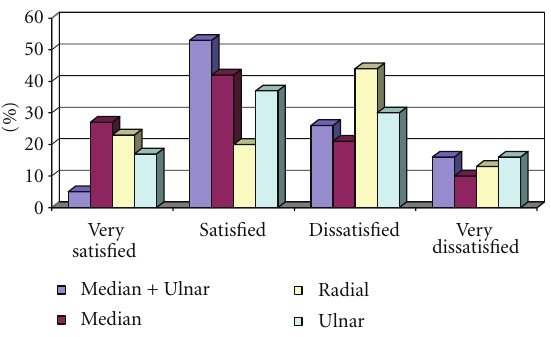
Figure 2: Patient-rated